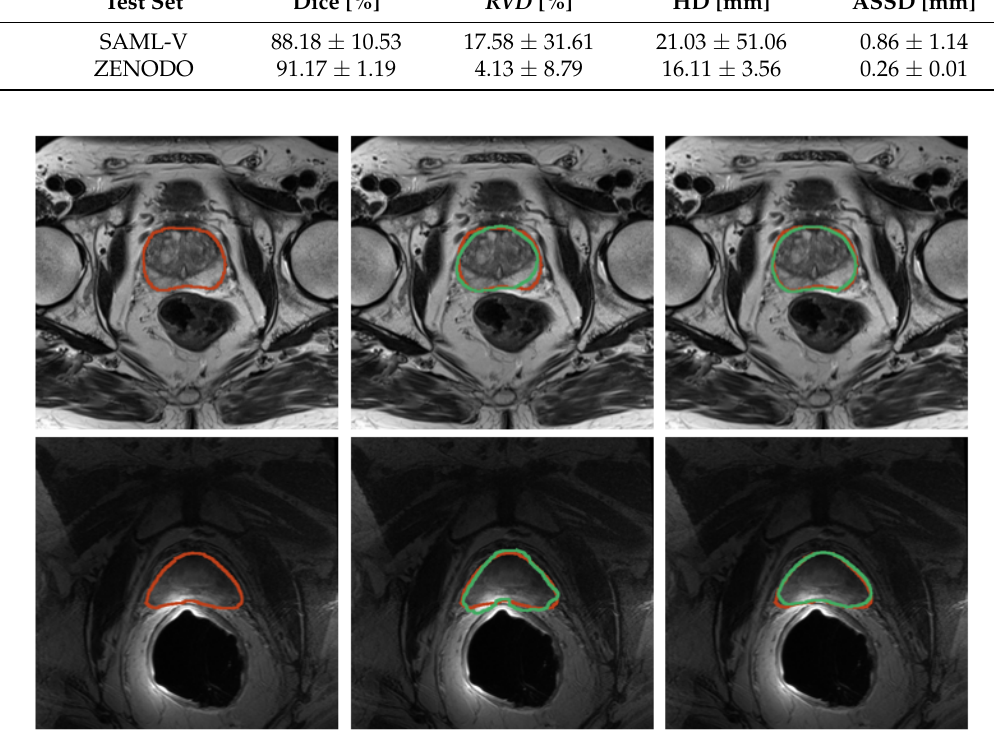
Figure 8. Results for prostate segmentation from MRI. Top row contains images from the SAML dataset and the second row contains images from ZENODO. The ground truth is represented in red, whereas the predictions from the nnU-Net models are colored in green. The middle image shows the prediction mask for the nnU-Net trained for only 10 epochs, whereas the right image depicts the prediction mask for the one trained on the PROMISE12